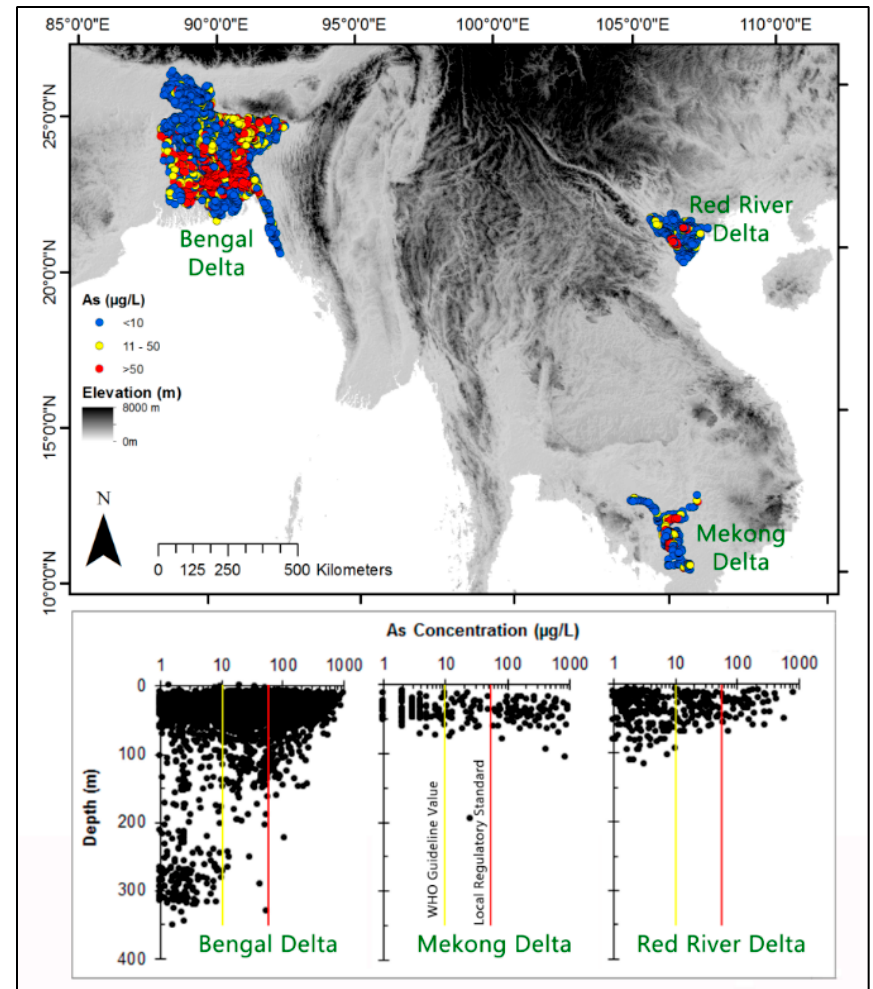
Figure 1. Location of the East and Southeast Asian deltas and coverage of data [19,22,35–37] used in this study. Elevation (based on [38]) variation across the region indicate the topography and landscape. Depths covered by the dataset for a whole range of ions are illustrated by As.